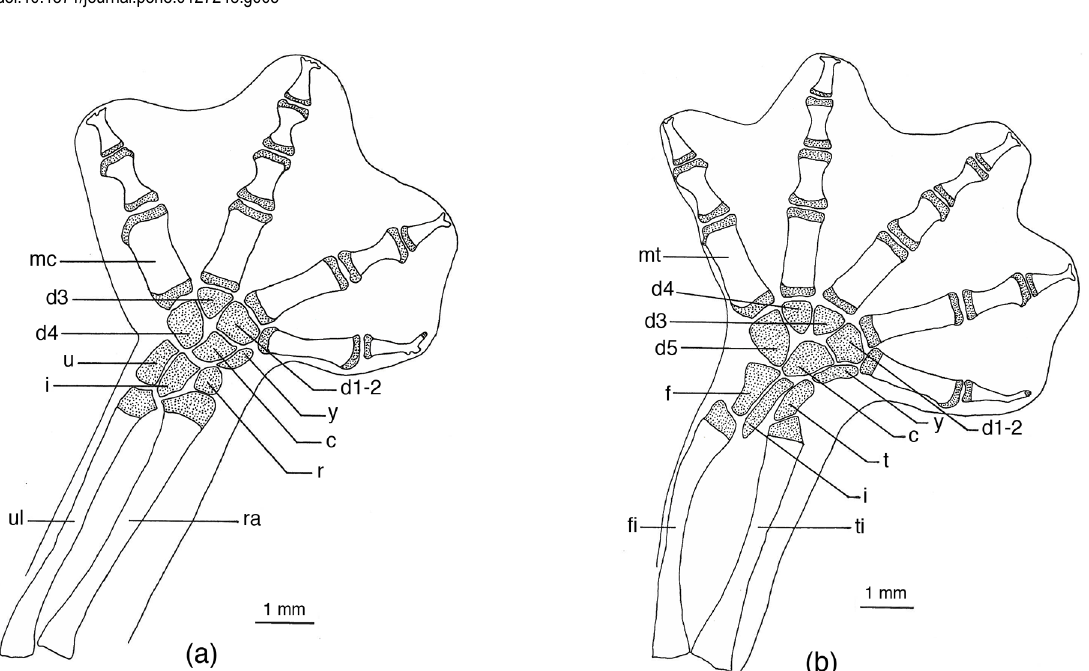
Fig 6. Chiropterotriton magnipes feet. Drawings of front, left (a) and rear, left (b) feet of Chiropterotriton magnipes (MVZ 129013), showing skeletal elements and the extent of interdigital webbing. Dorsal view; stippled areas represent cartilage. Abbreviations: c = centrale, d = distal carpals and tarsals, f = fibulare, fi = fibula, i = intermedium, mc = metacarplas, mt = metatarsals, r = radiale, ra = radius, t = tibiale, ti = tibia, u = ulnare, ul = ulna, y = element y.